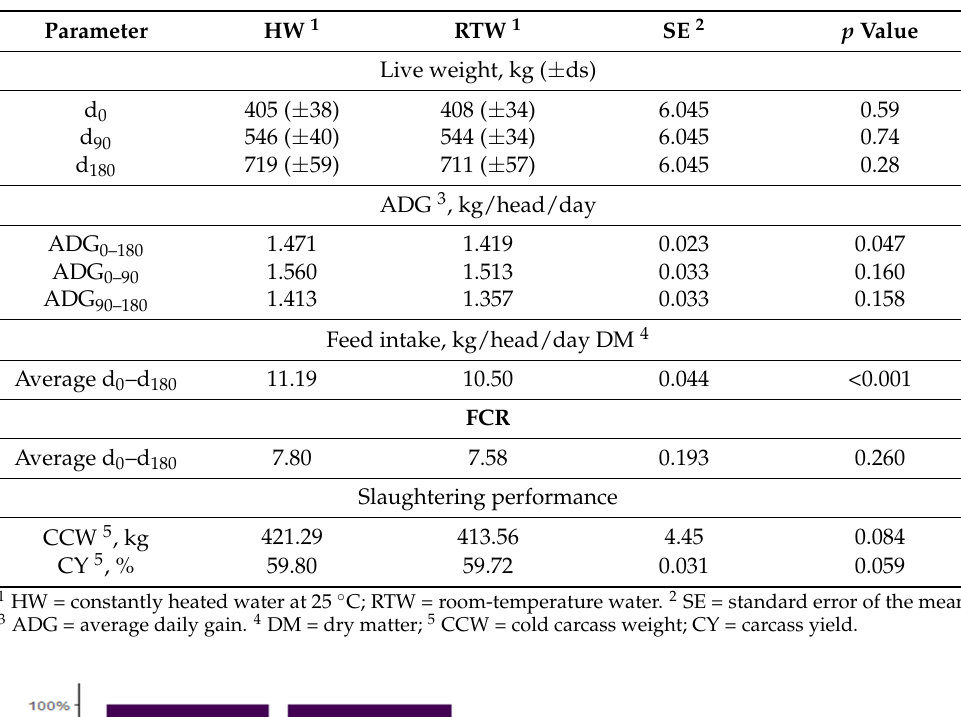
Table 3. Growth performances and feed conversion rates of the two experimental groups.